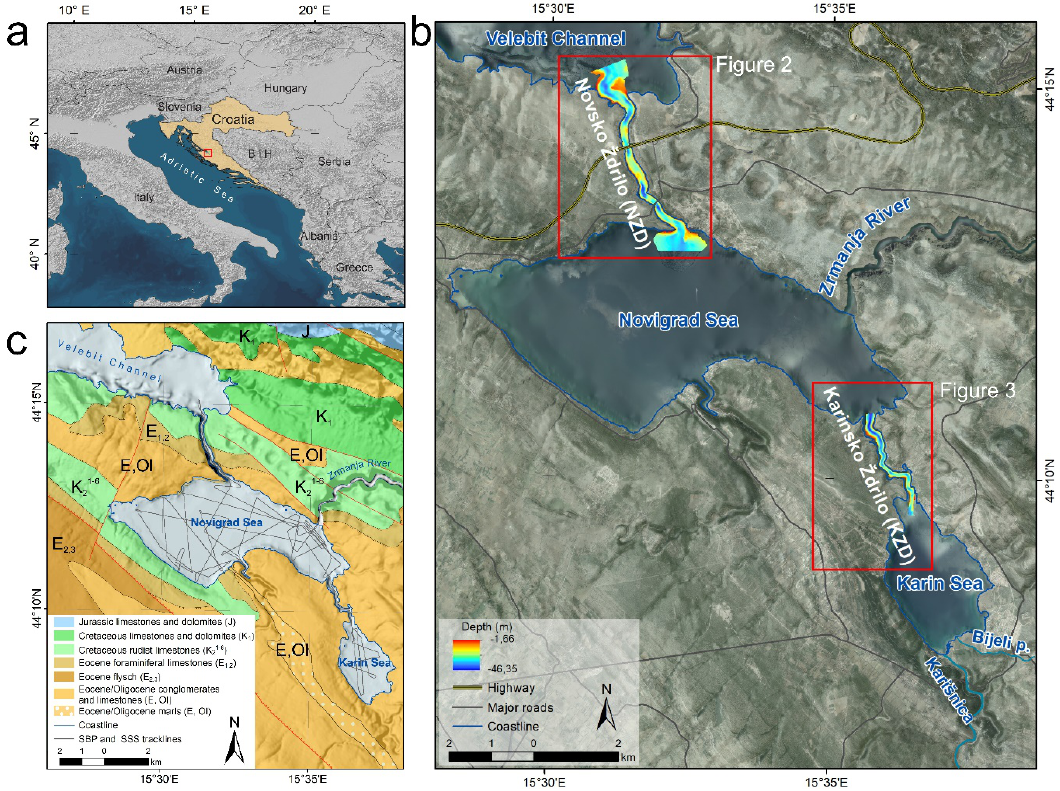
Figure 1. ( a ) General study site location in the red square. ( b ) Multibeam echosounder (MBES) bathymetry data for Novsko Ždrilo (NZD) and Karinsko Ždrilo (KZD) draped over a shaded relief and an orthophoto map [27]. The study areas are highlighted with red squares and presented in detail in Figures 2 and 3. ( c ) Geological map with the plotted sub-bottom profiling (SBP) track